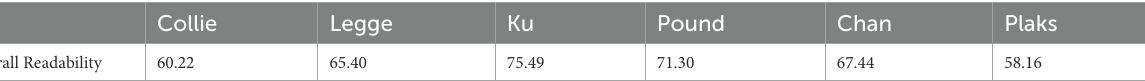
TABLE 10 Overall readability of the six TTs (in Flesch Reading Scale).